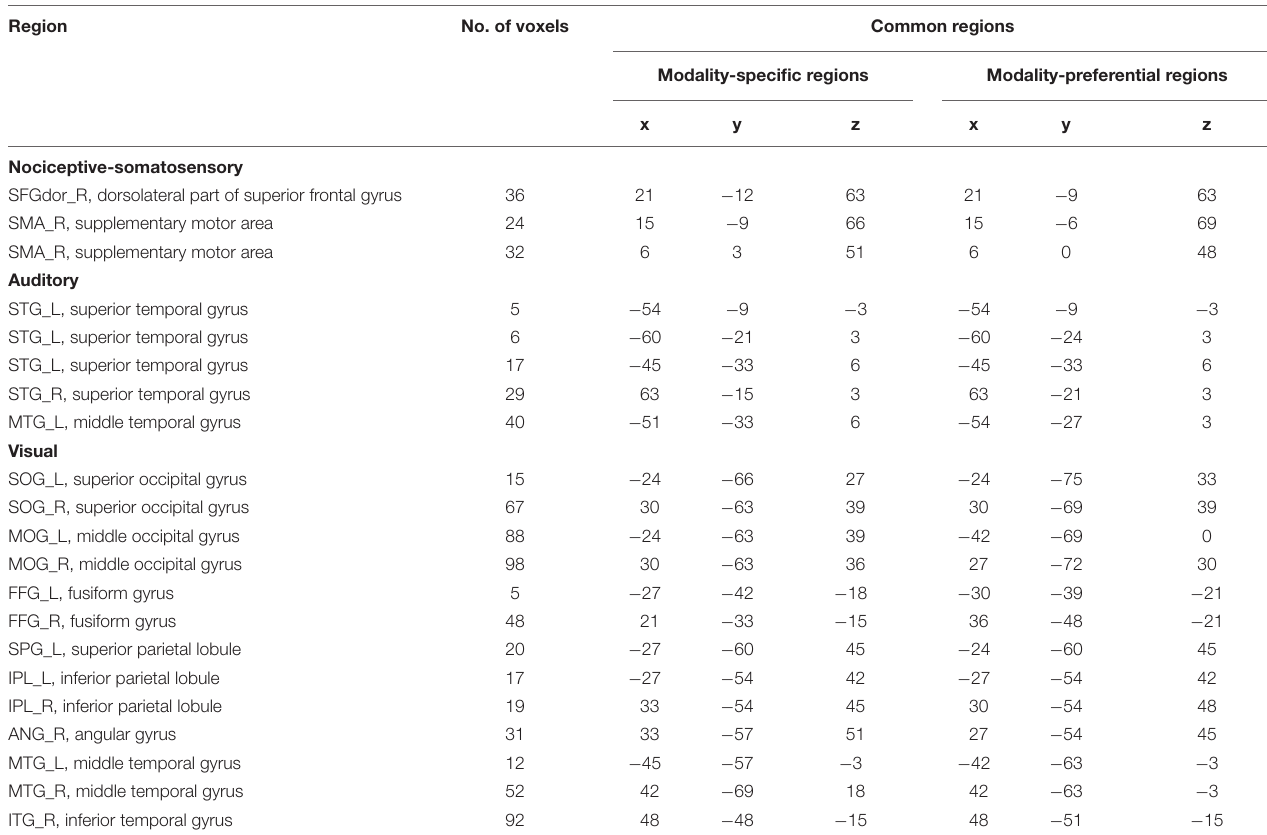
TABLE 3 | Common regions of modality-specific regions and modality-preferential regions. Region No. of voxels Common regions